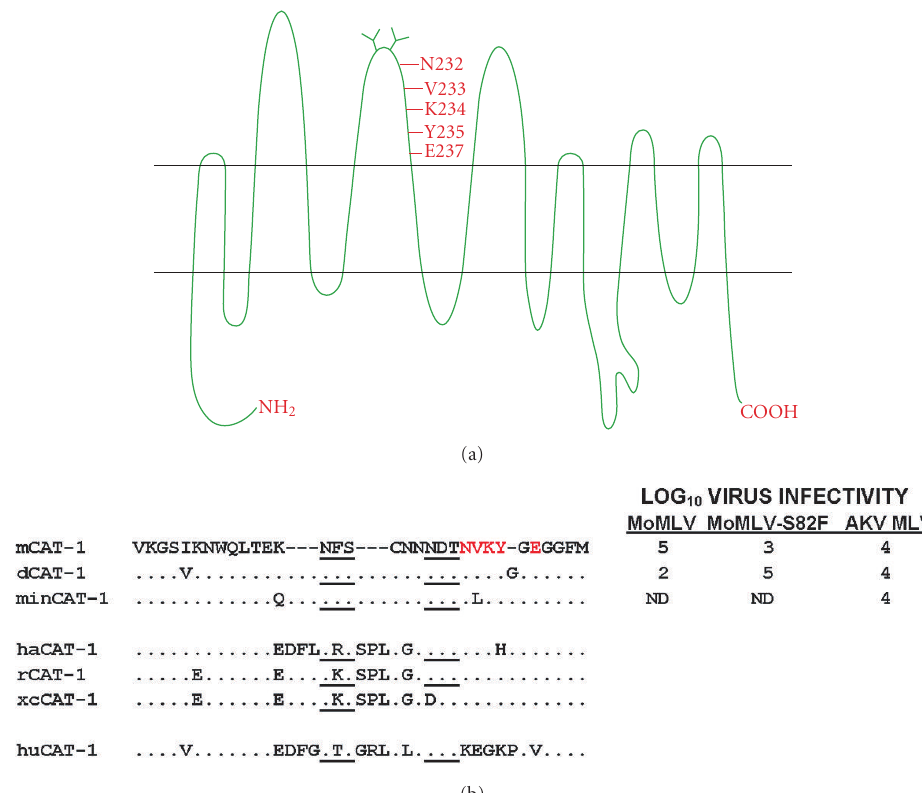
Figure 1: Predicted topology and sequence variation of the CAT-1 receptor for mouse ecotropic gammaretroviruses. (a) Putative topology identifies 14 predicted transmembrane domains. The third extracellular loop contains critical residues for receptor function (in red) and two N-linked glycosylation sites. (b) Sequence variation in the CAT-1 third extracellular loop. At the top are three sequence variants found in Mus with residues critical for entry in red. Virus infectivity of cells expressing these receptors is measured as the log 10 titer of FFU/100 μ L of viral Env pseudotypes carrying the LacZ reporter gene; ND: not done. Consensus sites for N-glycosylation are underlined. CAT-1 sequence variation is shown for mouse CAT-1 variants mCAT-1 (NIH 3T3), dCAT-1 ( M. dunni ), and minCAT-1 ( M. minutoides ). E-MLV-infected Mus species M. castaneus , M. molossinus , M. spicilegus , and M. musculus are identical to mCAT-1 in the indicated region. Also shown are CAT-1 sequences for virus-susceptible species hamster (ha), rat (r), and XC rat cells (xc) and for virus-resistant human